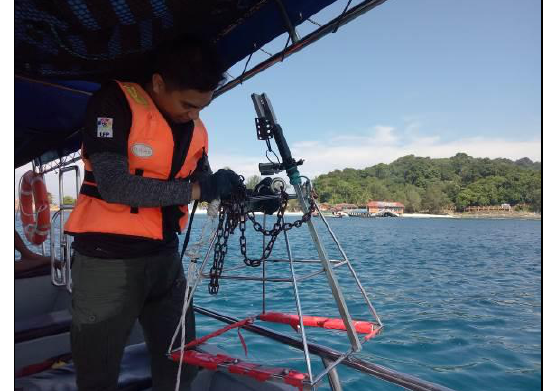
Figure 2. Visual in-situ sampling using GoPro Hero 4 mounted on a customize cage.